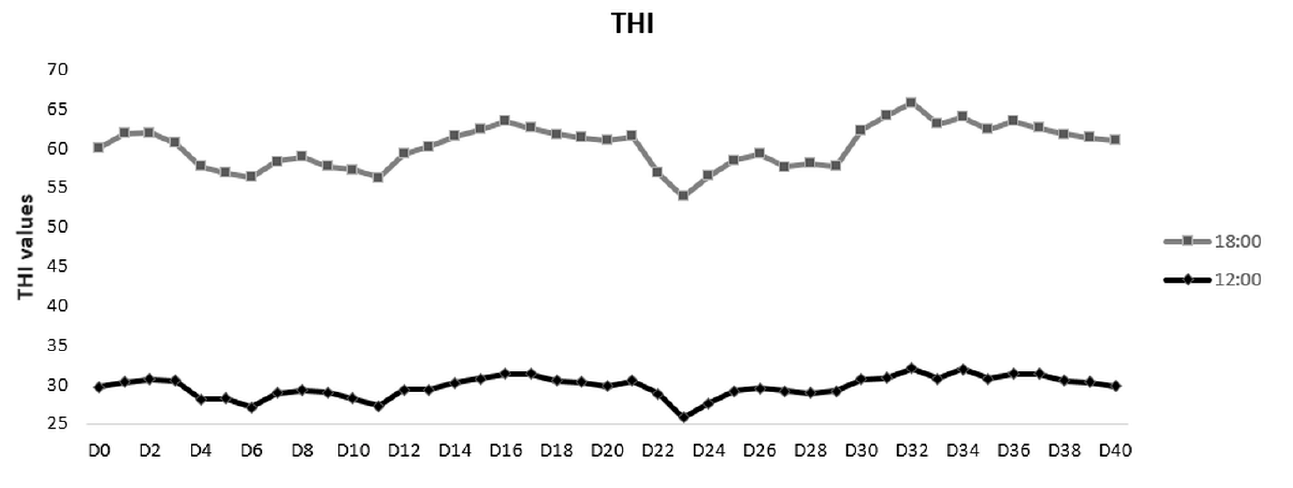
Figure 2. Temperature- Humidity Index (THI) throughout the study, estimated twice daily (12.00 and 18.00 h).